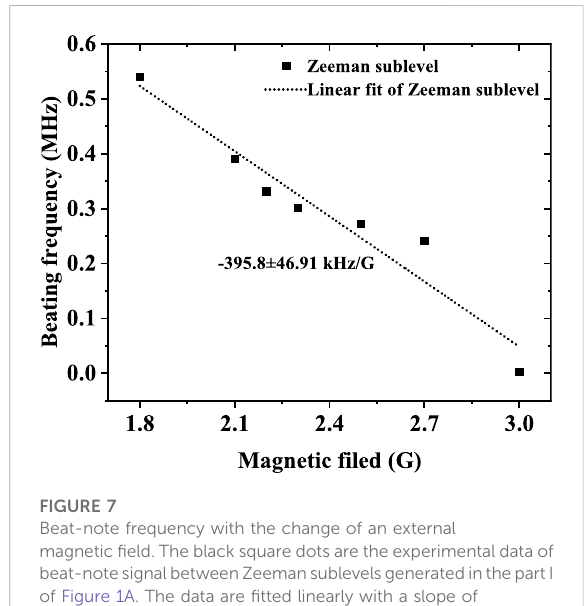
FIGURE 6 Beat-note frequency with the change of power of 459 nm laser. The red dots are the experimental data of the beat-note signal between AOC lasers generated in the part I and part II of Figure 1A without an applied magnetic fi eld. Its linear fi tting result is indicated by the red dotted line with a slope of 0.481 ± 0.066 MHz/mW.